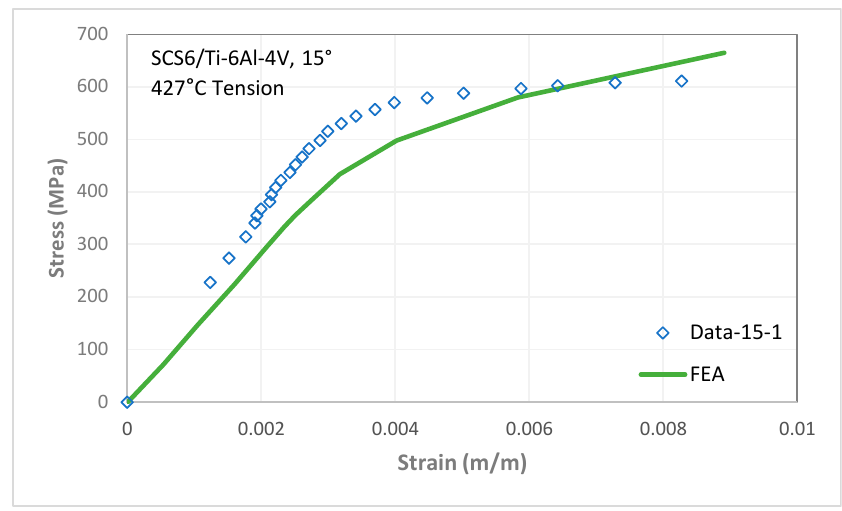
Figure 12. Stress-strain response for 15° off-axis at 427 °C.